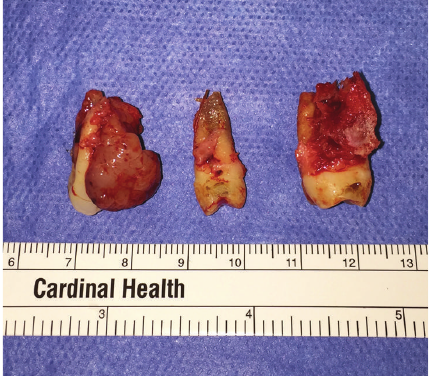
Figure 6: Extracted teeth numbers 24, 25, and 26 (international nomenclature). A portion of the recurrent lesion is seen attached to the distal aspect of tooth number 24 (international